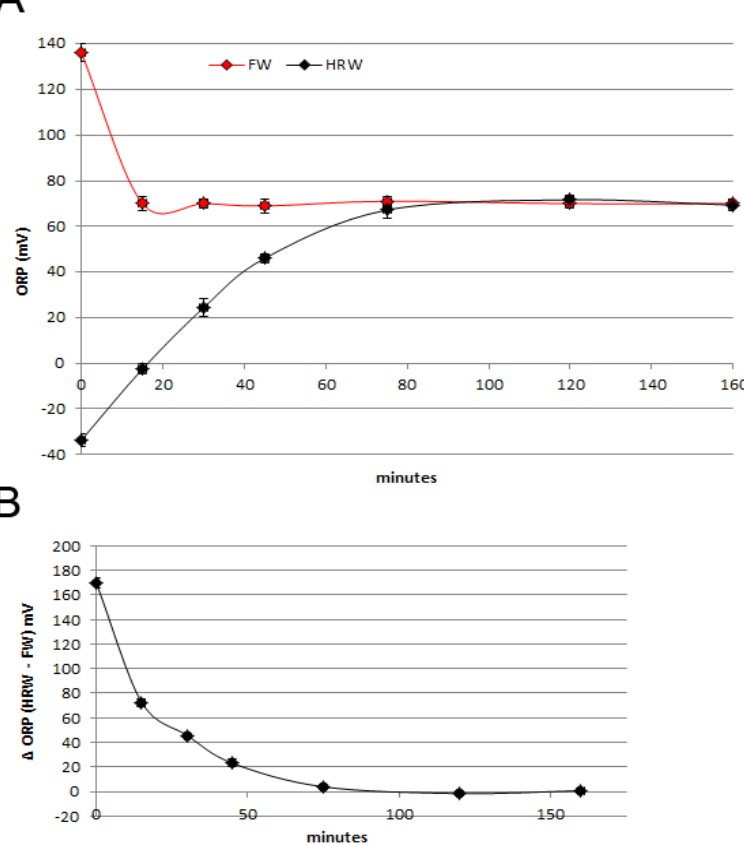
Figure 2. ( A ) ORP measurements performed on FW and HRW right after production: dilution of HRW and withdrawal of FW from the ZEBTEC© system. FW ORP quickly drops from about 140 mV to a stable level of about 70 mV. ( B ) ORP difference between FW and HRW expressed as ∆ ORP (HRW ORP − FW ORP, mV), which reaches 0 after about 75 min.